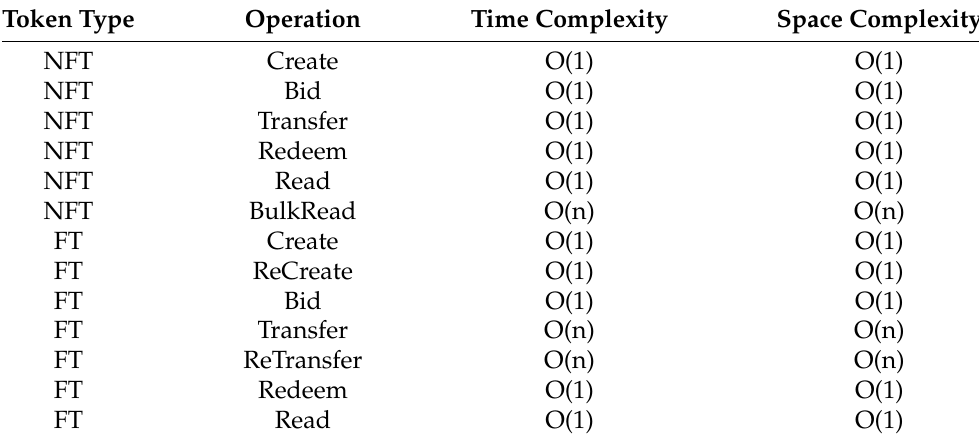
Table 2. Time and space complexities of